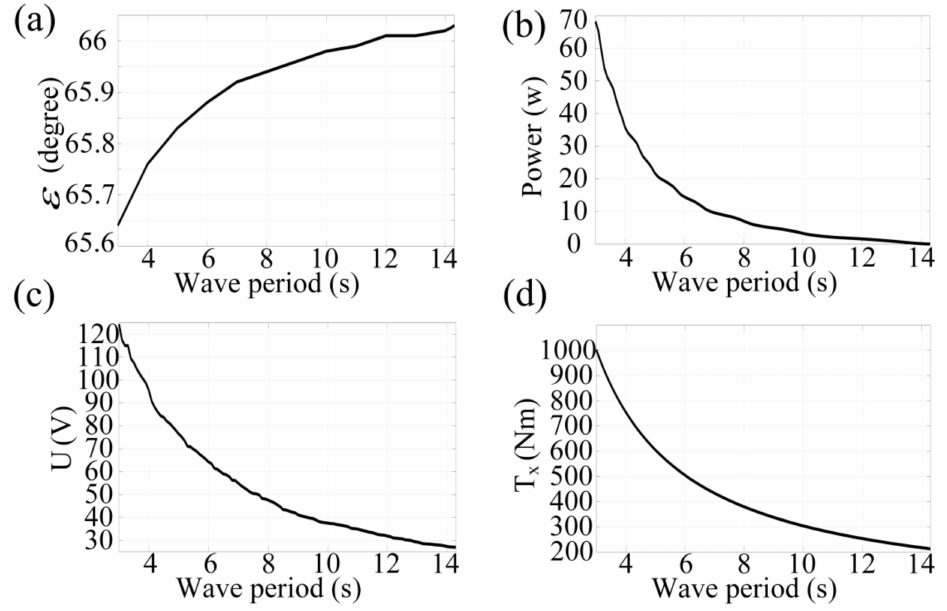
Figure 11. The effect of wave period: ( a ) flywheel precession angular displacement; ( b ) output power; ( c ) voltage; ( d ) torque in x